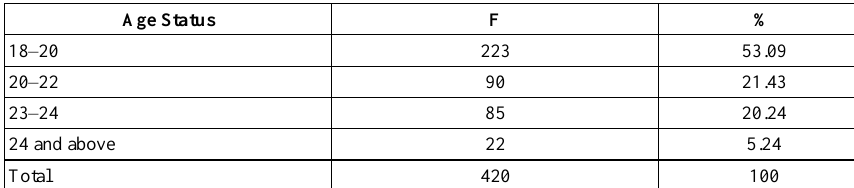
Table 3. Distribution of university students by